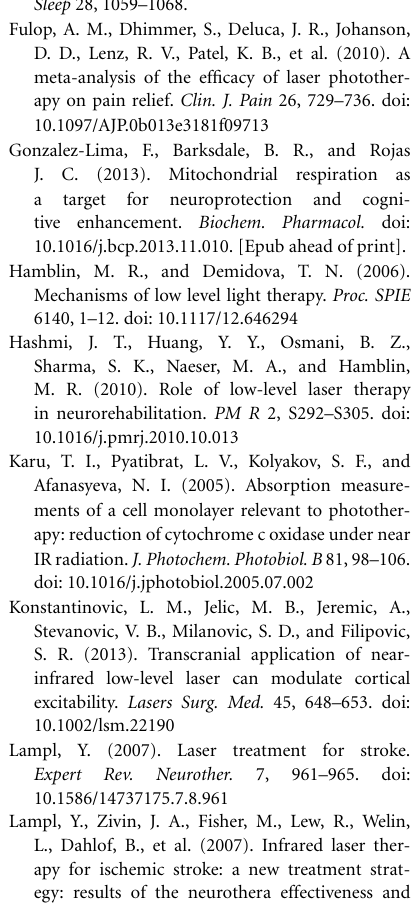
pattern. The function of frontal cortex regions, implicated in the attentional mode network utilized during this visuospatial memory task, was augmented by the laser treatment. Compared to baseline, this treatment also increased by 5% the oxyhemoglobin concentration of the prefrontal cortex as measured by near-infrared spectroscopy, both during the laser stimulation and during post-treatment DMS performance (in preparation). The data for the treated group consisted of n = 10 males and n = 10 females; the control group also consisted of n = 10 males and n = 10 females. ∗ Significant treatment by pre-post score interaction, p < 0 .